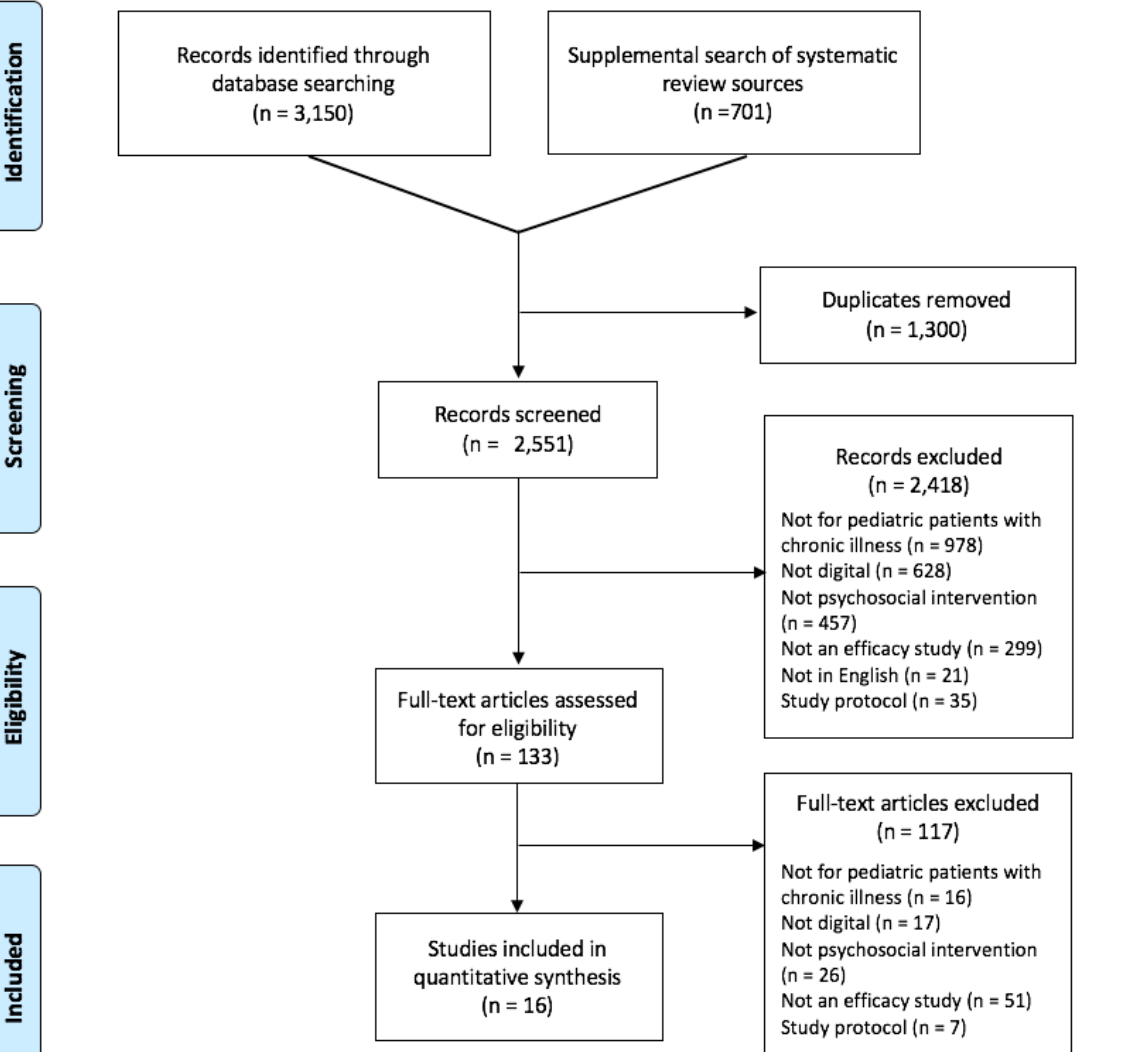
Figure 1. Preferred reporting items for systematic reviews and meta-analyses